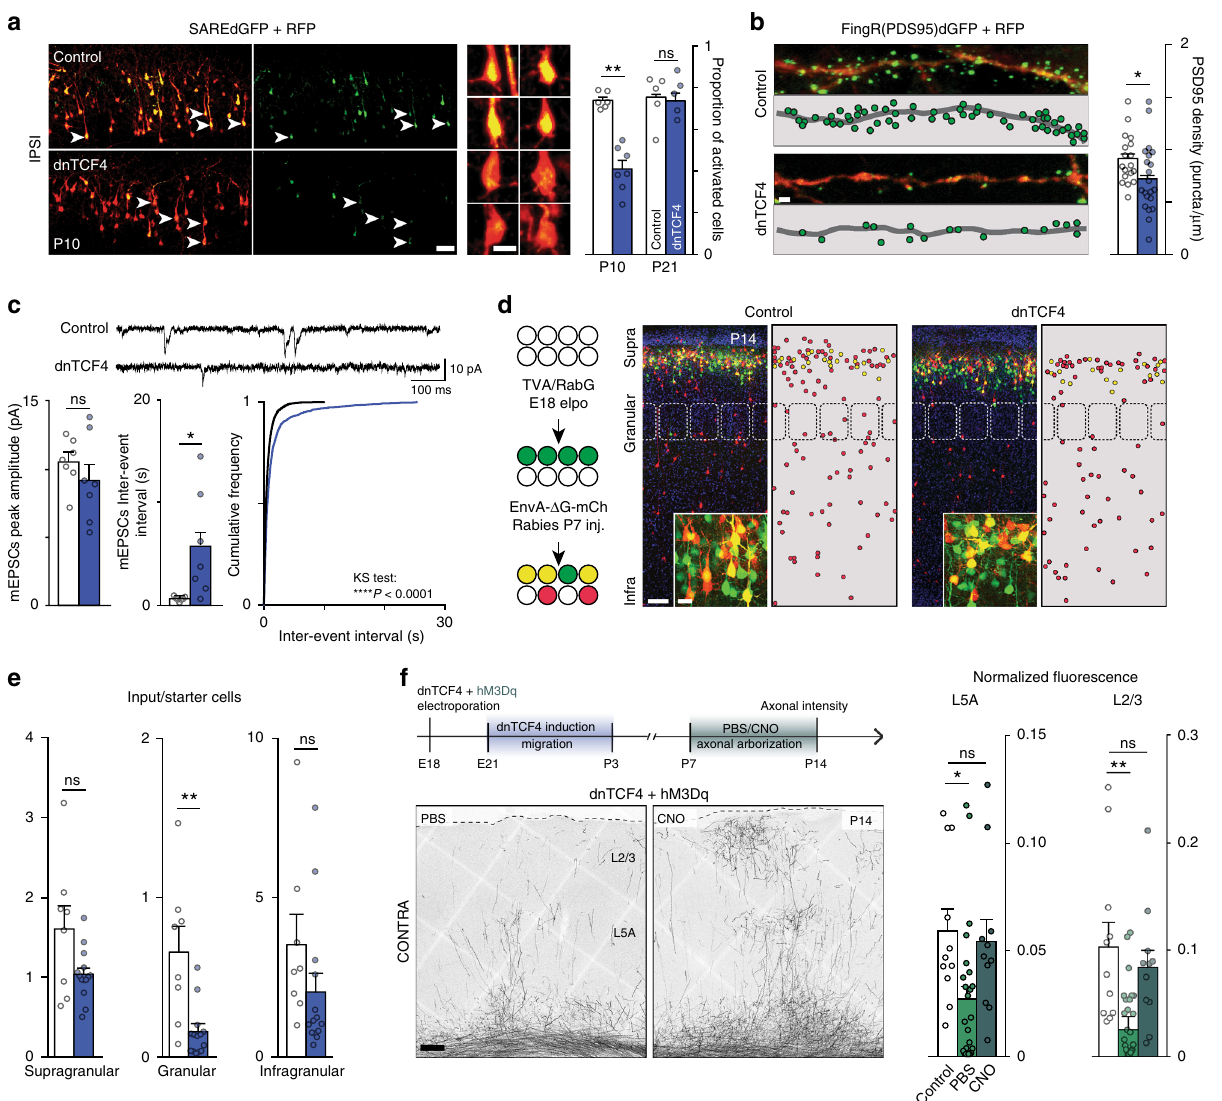
Fig. 5 Delayed callosal projection neurons display reduced synaptic input and reduced neuronal activity. a Activity-reporter (SAREdGFP) shows decreased GFP expression in late-arrived neurons (arrowheads mark activated cells, magni fi ed at right). Graph shows the proportion of GFP-positive activated cells during axonal arborization (P10) and at P21; n = 6 and 7 brains (Control vs. dnTCF4, respectively) at P10 and n = 5 brains at P21, Mann – Whitney, P > 0.9999 for P21. b Excitatory connections labeled by PSD-95-speci fi c FingR-GFP showing a decreased number of synaptic puncta in neurons with delayed migration (dnTCF4); n = 18 and 21 cells from 3 and 4 brains (Control vs. dnTCF4, respectively), Mann – Whitney. c mEPSCs recording samples of layer 2/3 pyramidal neurons for control (top trace) and dnTCF4 (bottom trace) P14-P15 animals. No signi fi cant difference in amplitude and a signi fi cant increase in mEPSCs inter-event interval for dnTCF4 animals; n = 7 animals per group, 1 cell per animal, Student ’ s t test (bar graphs, P > 0.9999 for P21), Kolmogorov – Smirnov test (cumulative distribution). d Rabies-mediated monosynaptic retrograde tracing (schematized at left) shows reduced afferent inputs on late arrived (dnTCF4) starter cells, magni fi ed inserts display equal density of starter cells. e Quanti fi cation of input/starter cells shows a major reduction of inputs from the granular layer; n = 8 and 14 brains (Control and dnTCF4, respectively), Mann – Whitney, P = 0.1876 for supragranular layer. f The timeline showing the experimental design used for rescuing aberrant callosal projections via hM3Dq DREADD receptor activation. Daily clozapine- n - oxide (CNO) injections were performed during axonal arborization. Chemogenetic stimulation of late-arrived CPNs rescues contralateral arbors compared to non-activated neurons (PBS injection); n = 11, 24, and 11 brains (Control, PBS, CNO, respectively), Kruskal – Wallis, Control vs. CNO: P = 0.5455 for L5A P > 0.9999 for